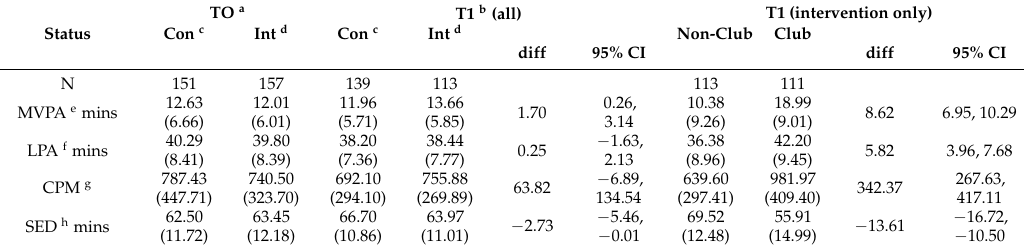
Table 2. Post hoc exploration of mean (SD) PA and sedentary time after-school between 3–5 p.m. TO a